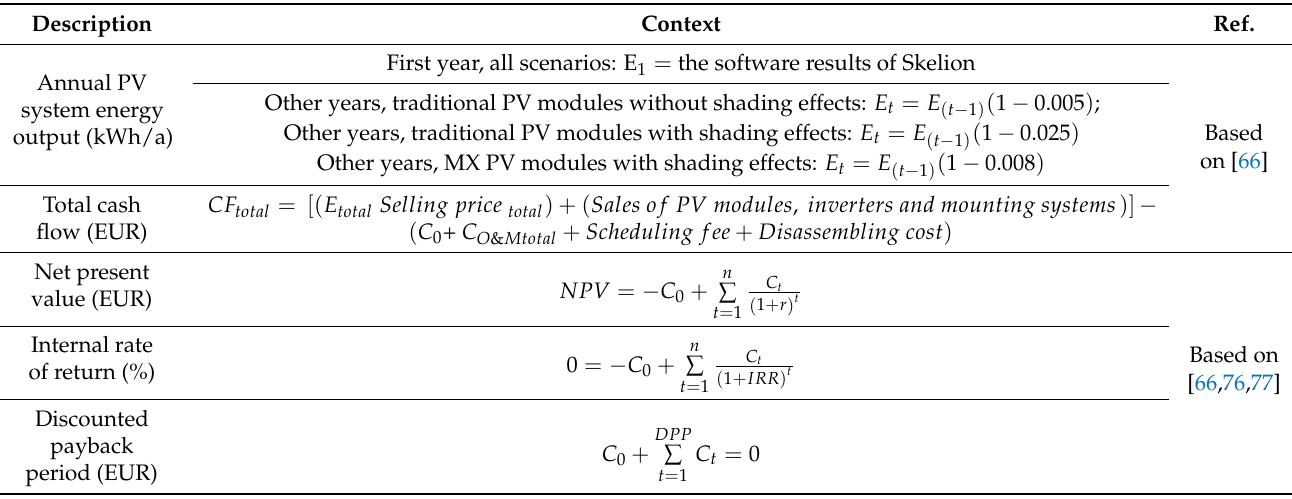
Table 2. The main context of the economic calculations of the modeling.